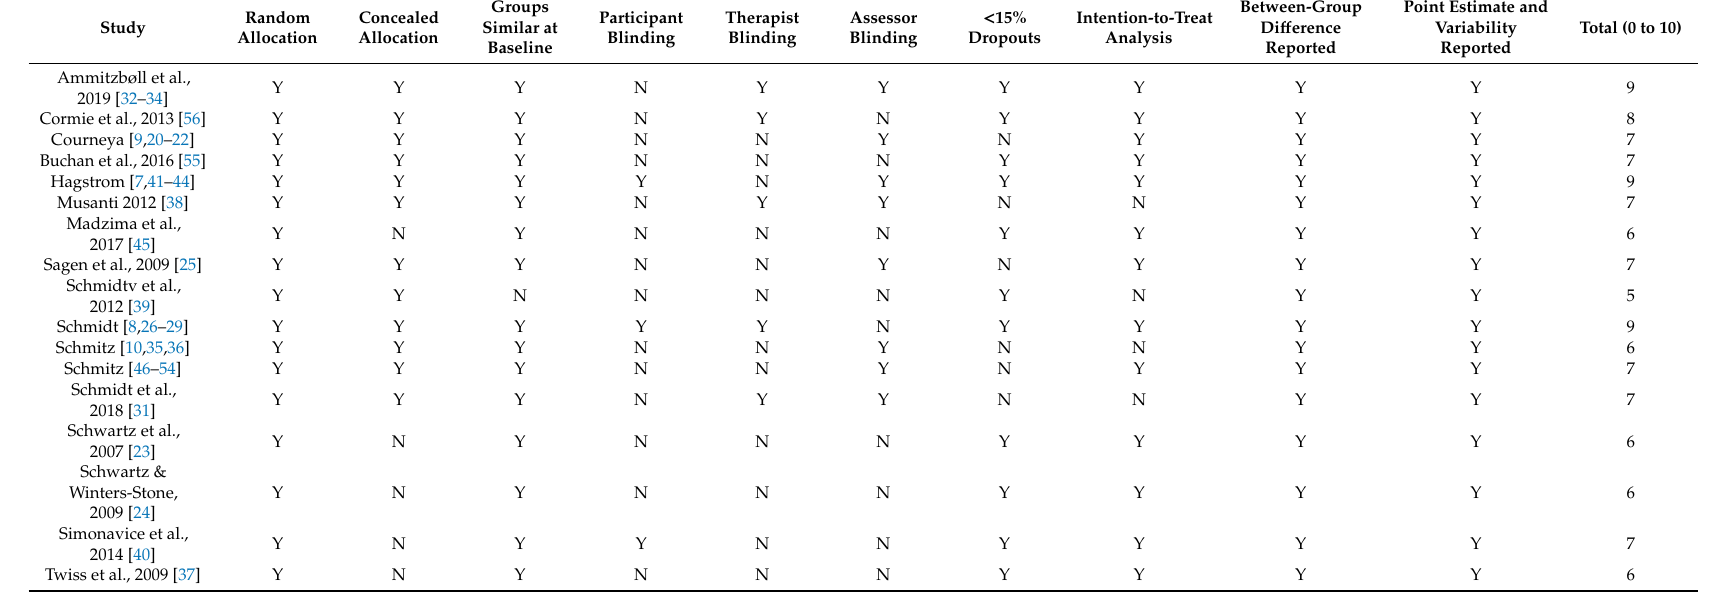
Table 5. Physiotherapy Evidence Database (PEDro) scores of the included trials (n =